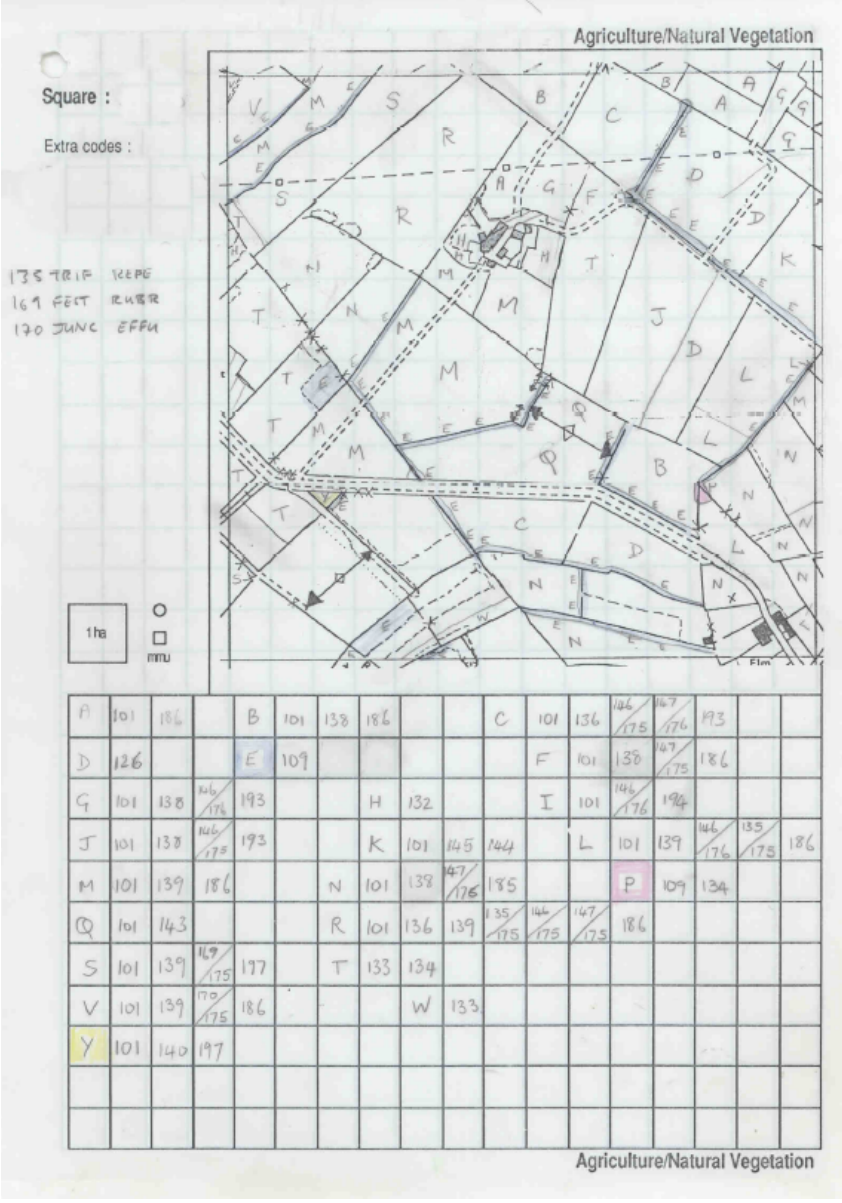
Figure 3. Example of a field mapping